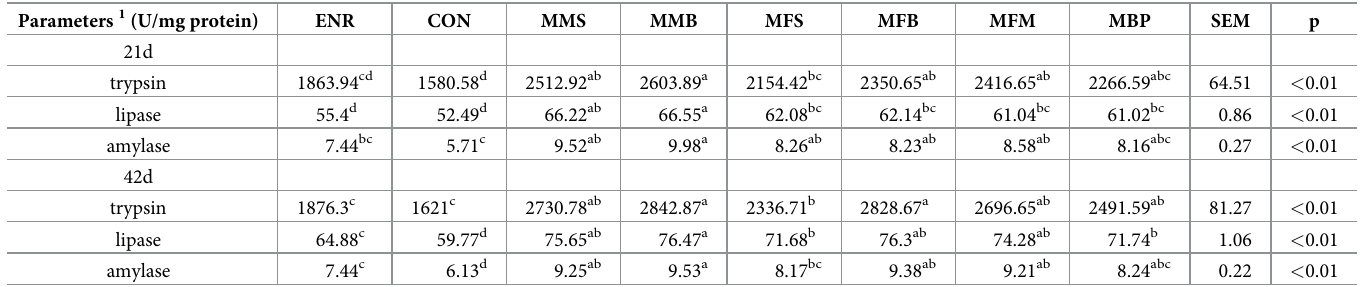
Table 4. Effects of dietary nonantibiotic alternative growth promoter combinations on duodenal digestive enzyme activity of broilers at 21 and 42 days. Parameters 1 (U/mg